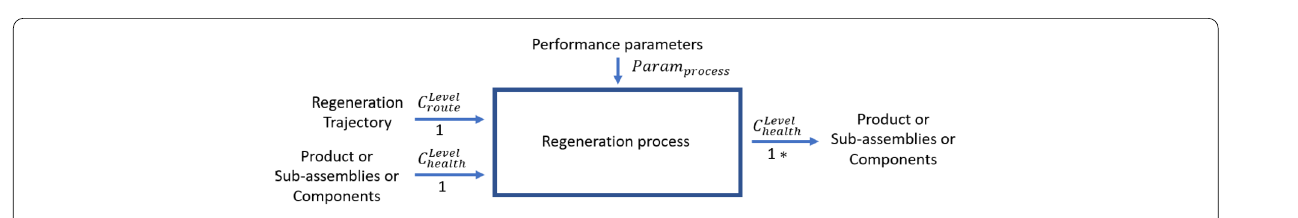
Figure 9 Input/Output of Regeneration process